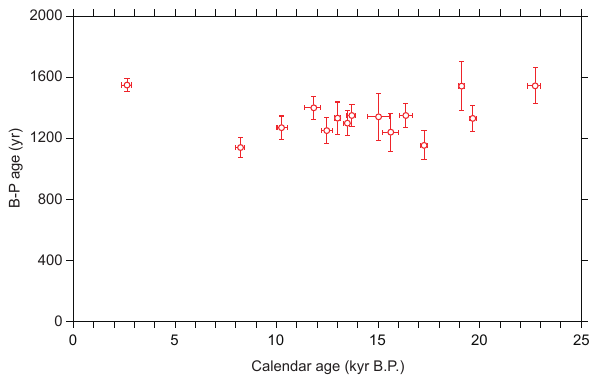
Fig. 3. Changes in 14 C age offset between coexisting planktic and benthic foraminiferal shells (B-P age) in core MD01-2420 during the last 25kyr. Errors are ± 1 σ .